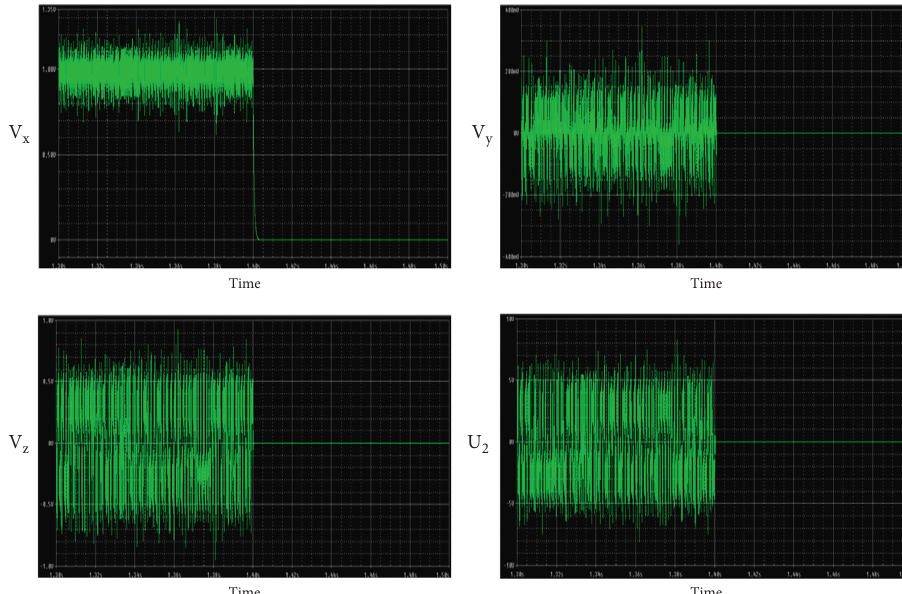
Figure 10: Time series of chaos suppression in SynRM without external inputs generated from the Pspice oscilloscope for the capacitors and resistors: C R � 3 . 33 k Ω . 6